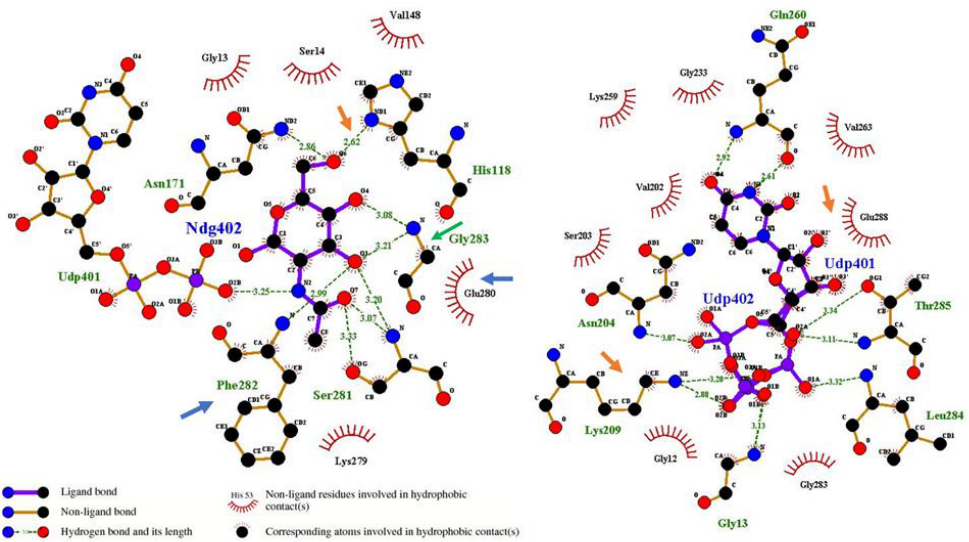
Figure 5. Putative ligand binding residues in NmW-GT based on the modeling template. Ligand- proximal residues in the template structures were identified with LigPlot+. Arrows point to the ligand-proximal residues that are conserved in BshA and NmW-GT.